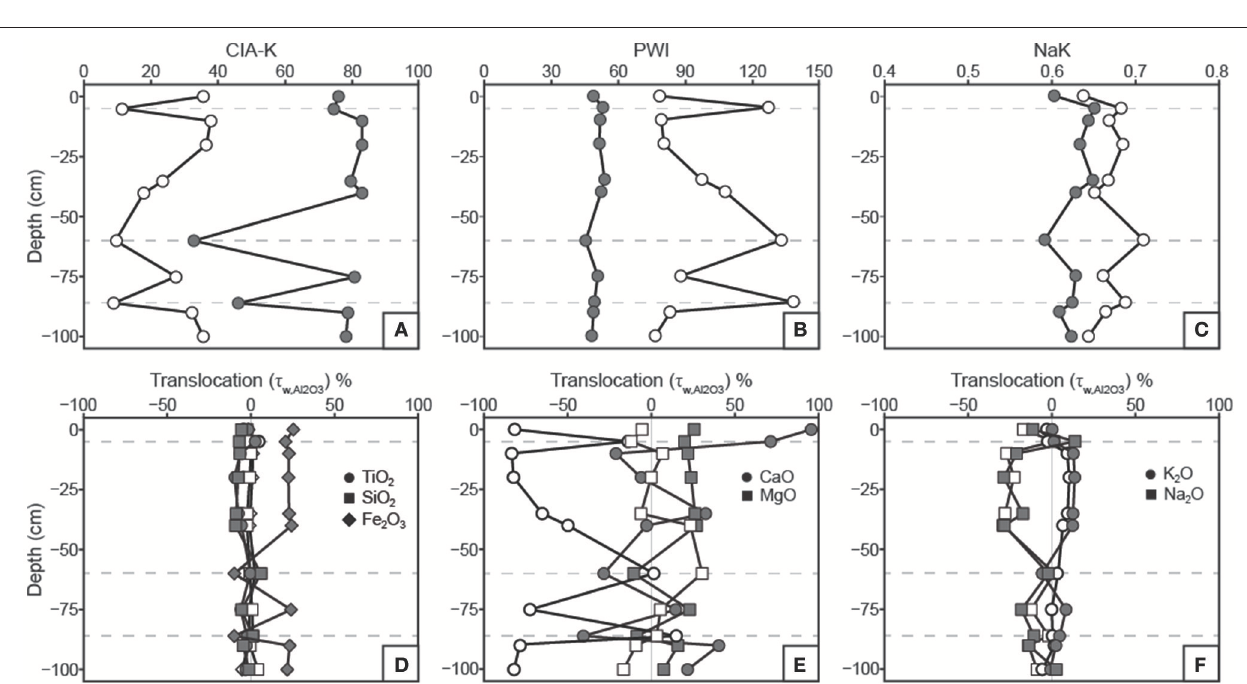
FIGURE 7 | Profiles of weathering indices and constitutive mass-balance results. See Table 1 for weathering index formulae. (A) Chemical index of alteration minus potassium (CIA-K) values increase with decarbonation as a result of CaO removal and Al 2 O 3 relative mass increase. (B) Paleosol weathering index (PWI) values decrease with decarbonation; note that lower PWI values correspond to more highly weathered, base-poor samples. (C) Salinization index (NaK) values are generally inversely correlated before and after treatment due to the relative increase in Al 2 O 3 with removal of CaO. (D) Translocation ( τ ) values indicate no down-profile change in TiO 2 or SiO 2 relative to parent material in either untreated or treated samples. Removal of carbonates resulted in a discernible increase in Fe 2 O 3 in B horizons, which matches the Fe index ( Figure 3 ). (E) The apparent CaO losses in B horizons for untreated samples does not appear after HCl treatment. No significant trends in MgO translocation are apparent. (F) Na 2 O and K 2 O show inverse translocation behavior, which are not affected by HCl treatment. Na 2 O loss is attributed to mineral